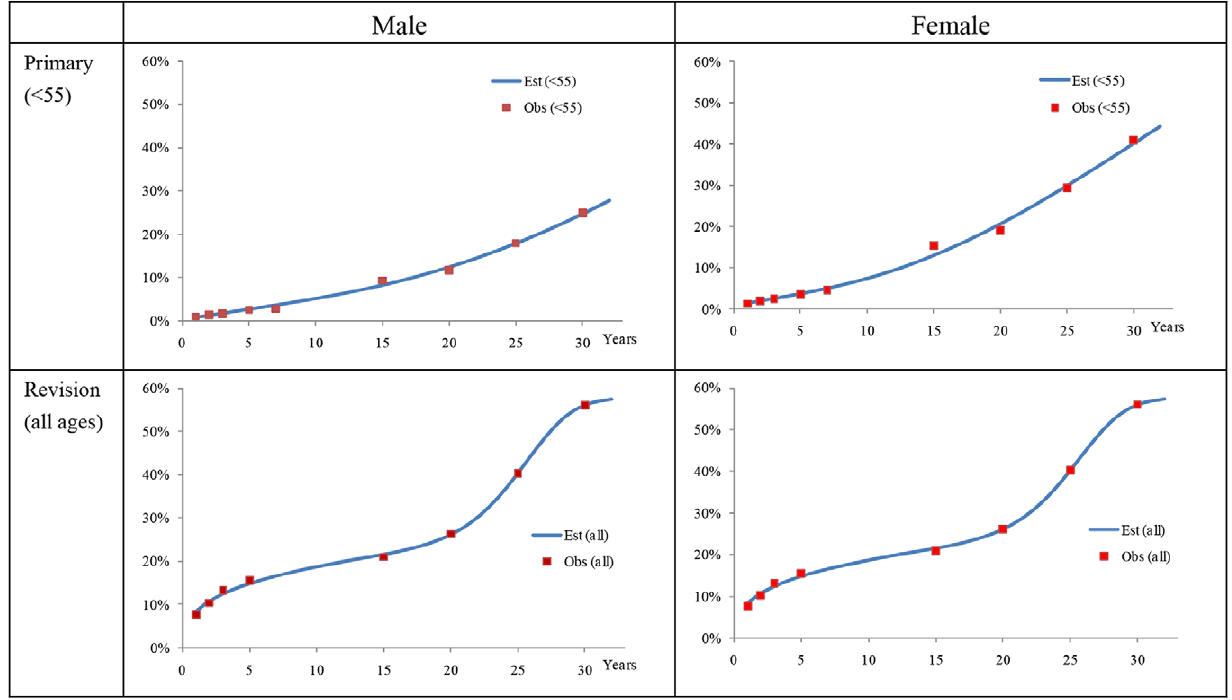
Figure 2. Cumulative distribution curve of time to revision with observed values (hip implants).